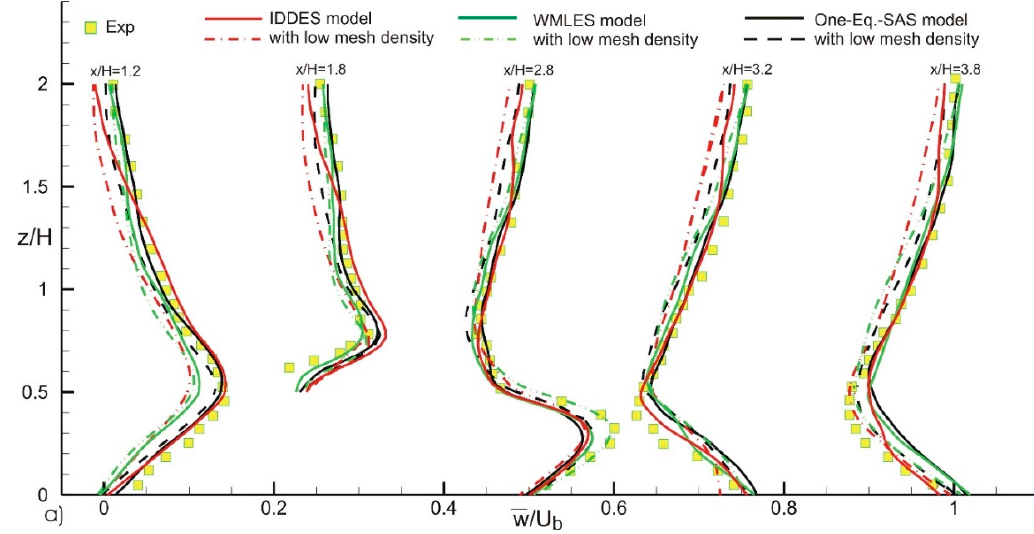
Figure 4. Effect of ( a ) mesh density, and ( b ) mesh clustering on the average streamwise velocity in the XZ plane cutting through the center of the cube at y/H = 0.5. Each successive x/H profile starting from the one at x/H = 1.2 is offset by one unit from the previous profile.